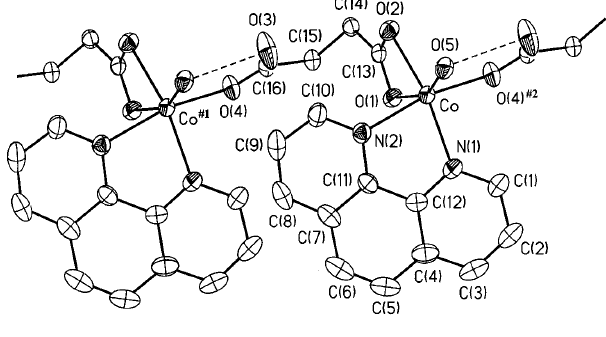
Table 1. Data collection and handling.